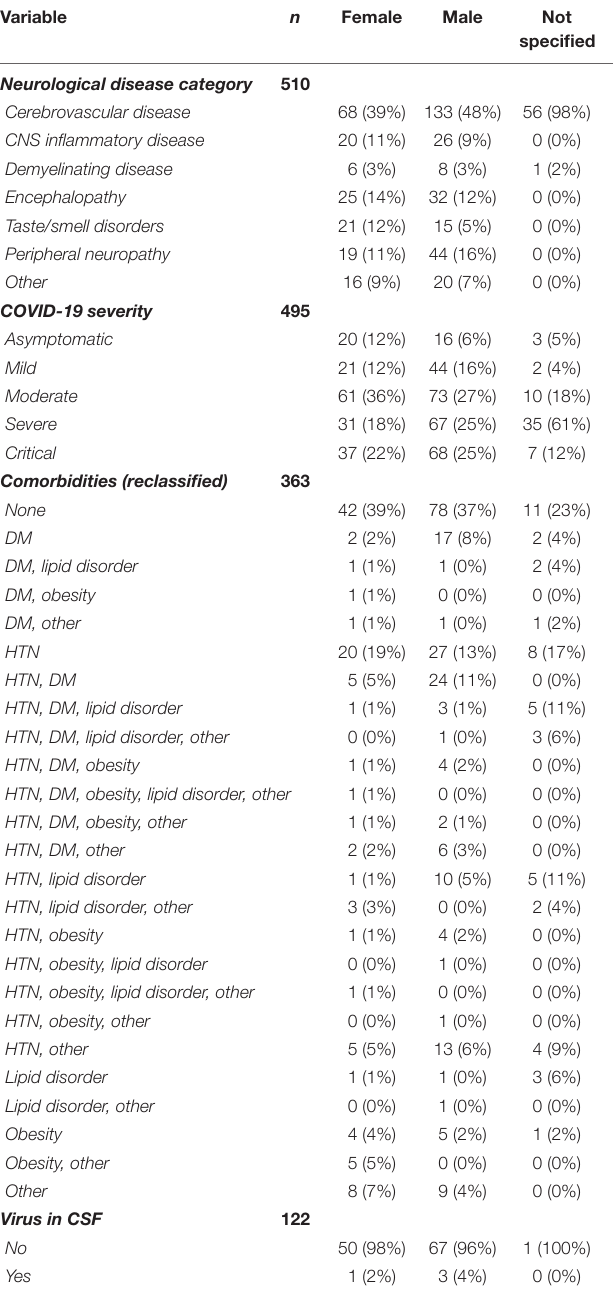
TABLE 4 | Frequencies and percentages of observed neurological disease split by COVID-19 severity ( n = 495). Neurological specified